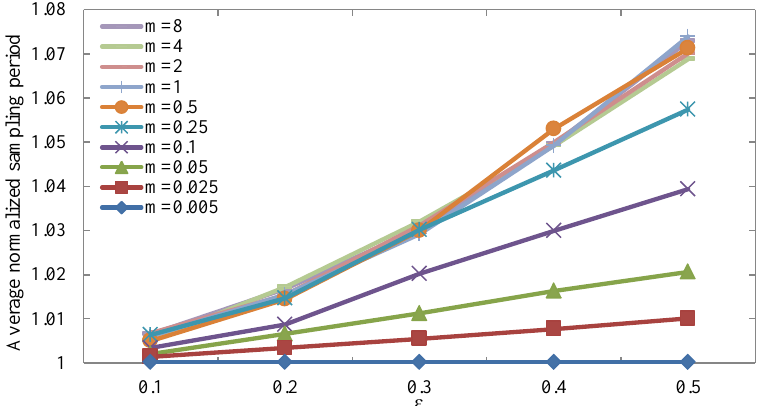
Figure 13 Normalized sampling period for synthesized